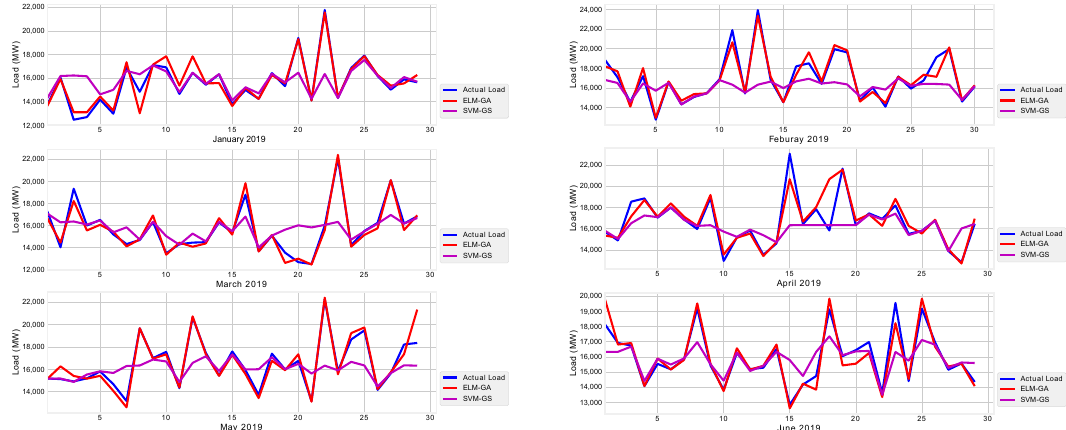
Figure 12. Comparison of forecasting results of different months with actual month load data.